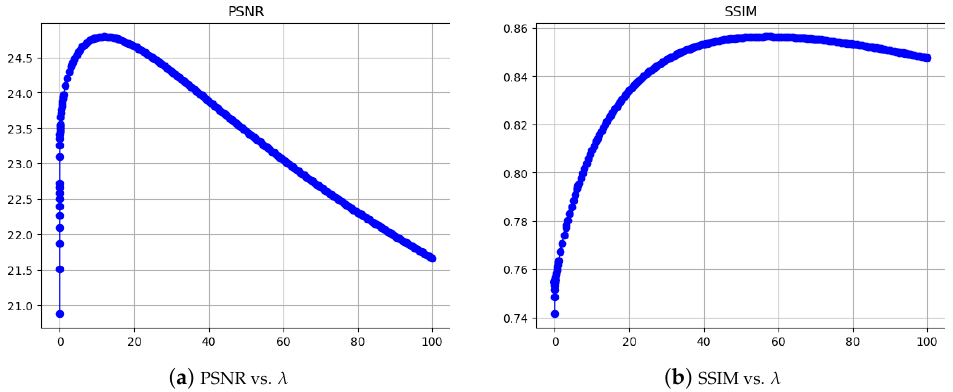
Figure 2. Motivation for the choice of the Stage 1 regularization parameter λ . ( a , b ) show the PSNR and SSIM as functions of λ . The curves here were obtained from the vessel-shaped phantom. Both SSIM and PSNR are rather insensitive to λ -values in the interval [ 15,35 ] , which contains our particular choice λ =